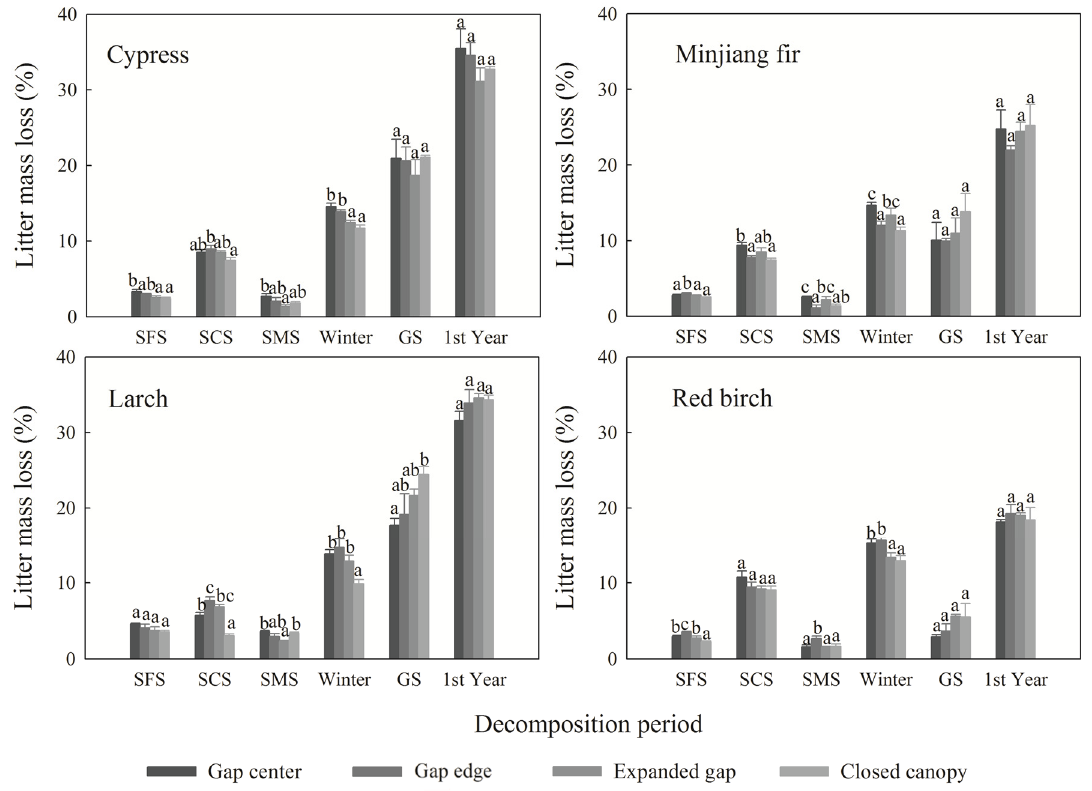
Figure 4. Litter mass loss (%) for the four types of foliar litter (cypress, Minjiang fir, larch, red birch) in the four gap positions (gap center, gap edge, expanded gap, closed canopy) for each decomposition period (SFP, snow formation period; SCP, snow cover period; SMP, snow melt period; Winter, all of winter; GS, growing season; 1st Year, the first year of litter decomposition) over the first year of litter decomposition in an alpine Minjiang fir forest. Different lowercase letters indicate significant differences among gap positions for the same decomposition period, p < 0.05 (mean ± SE, n = 3).